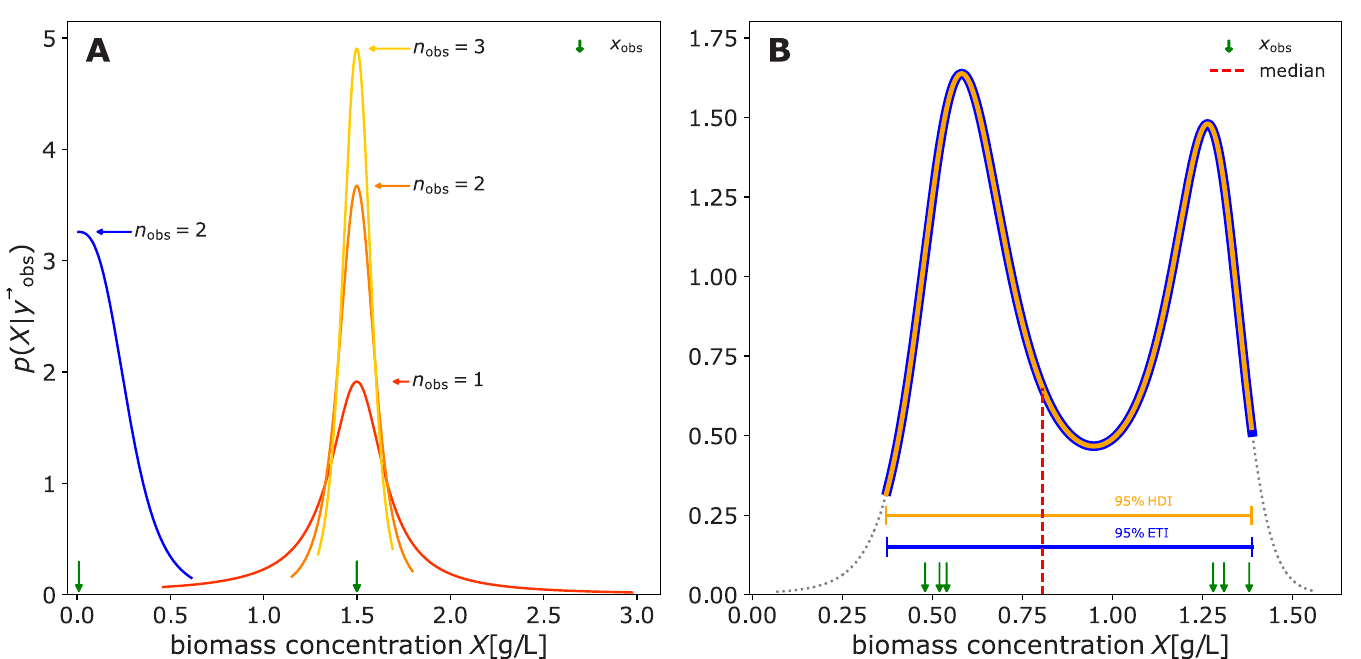
Fig 10. Independent variable PDFs in various observation scenarios. Posterior densities inferred from various numbers of observations corresponding to different biomass concentrations are shown ( A ). The ends of the drawn lines in A indicate the 95% equal-tailed interval. Near biomass concentrations of 0, the posterior density is asymmetric ( A , blue), indicating that very low concentrations cannot be distinguished. As the number of observations grows, the probability mass is concentrated and the ETIs shrink ( A , oranges). The choice of a Student- t distribution model can lead to a multi-modality of the inferred posterior density when observations lie far apart ( B ). For asymmetric distributions, the median (dashed line) does not necessarily coincide with a mode and equal-tailed and highest-density intervals (ETI, HDI) can be different. Maximum likelihood estimates from individual observations, as obtained via predict_independent are shown as arrows. Note: ~ y parameter were chosen at extreme values for illustrative